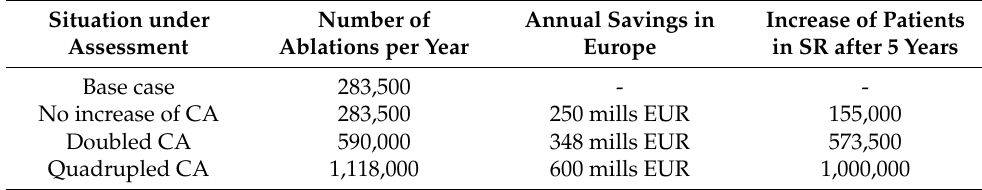
Table 5. Key values of the impact of the increase of ablations in Europe after five years with 25% more effectiveness of CA and including the price of the device. Situation